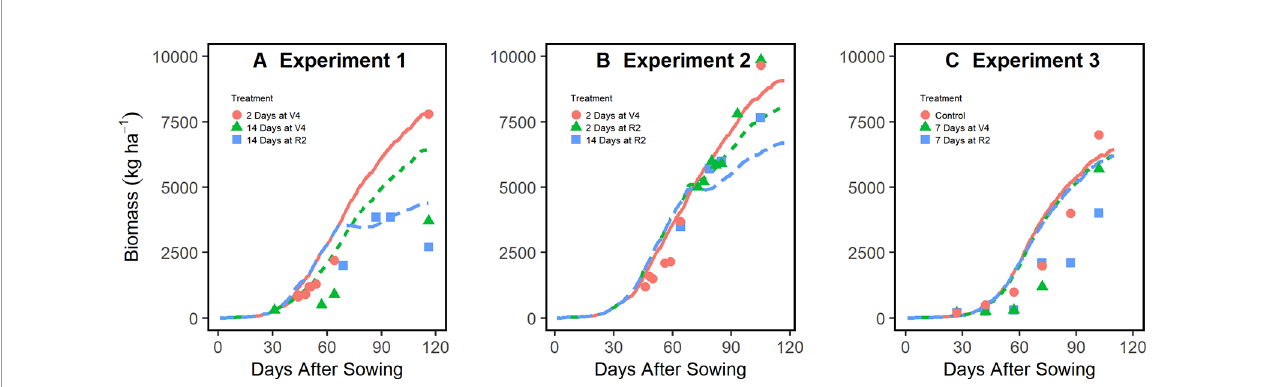
FIGURE 3 | In-season simulation of biomass accumulation under different fl ooding treatments in experiments 1 (A) , 2 (B) , and 3 (C) (all located in Arkansas, experiments 1 and 3 on Sharkey Clay soil and experiment 2 on Crowley Silt Loam soil; see Table 1 for more details). Lines represent APSIM model simulations, and points, the measured data from